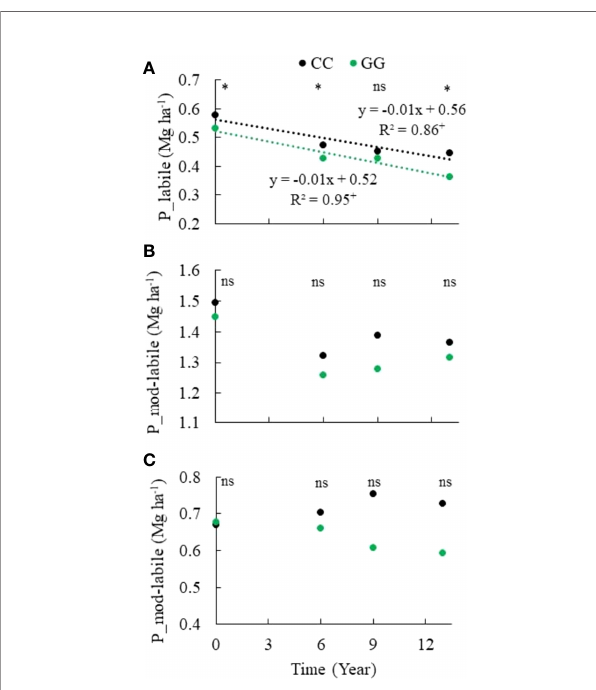
FIGURE 5 | Trends of (A) labile, (B) moderately labile, and (C) nonlabile phosphorus in the 0-30 cm topsoil layer under different soil management systems. CC – permanent conventional crop rotations (corn, winter wheat, and barley crops) and GG-permanent grassland. ns Not signi fi cant. *Signi fi cant in the Scott – Knott test (p ≤ 0.05). + Signi fi cant at p ≤ 0.01.